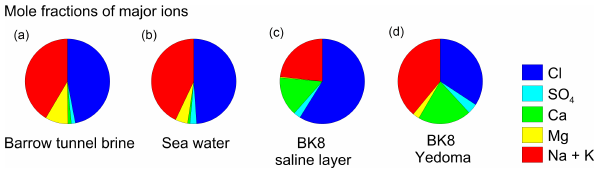
Figure 15. Comparison of major ion composition of (a) saline brine from the Barrow permafrost tunnel in Alaska (Colangelo-Lillis et al., 2016), (b) sea water with the pore water in the BK-8 Yedoma core from the lowermost saline layers (c) , and the overlying Yedoma (d)